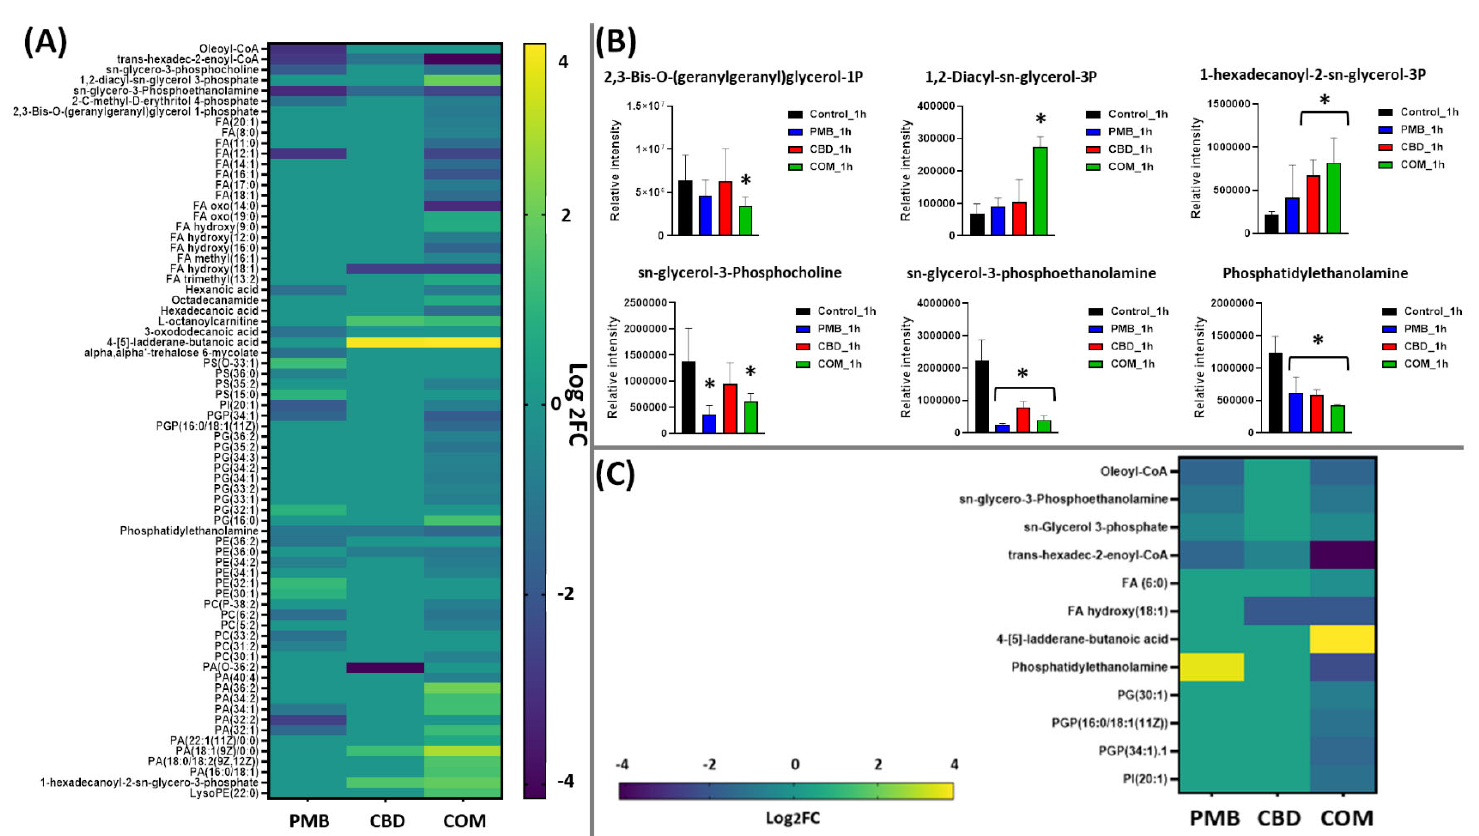
Figure 2. Perturbations of bacterial lipids. ( A ) Heatmap and ( B ) bar charts for significantly perturbed lipids in A. baumannii ATCC 19606 following treatment with polymyxin B (PMB, blue), cannabidiol (CBD, red) and the combination (COM, green) at 1 h. ( C ) Heatmap for significantly perturbed lipids in A. baumannii ATCC 19606 following treatment with polymyxin B (PMB, blue), cannabidiol (CBD, red) and the combination (COM, green) at 4 h. Lipid names are putatively assigned based on accurate mass ( ≥ 0.59 ‐ log 2 ‐ fold, p ≤ 0.05). Control, untreated samples; PE, phosphoethanolamines; PG, glycerophosphoglycerols; PS, glycerophosphoserines; PC, glycerophosphocholines; PA, glycerophosphates; LysoPE, lysophosphatidylethanolamines; PGP, glycerophosphoglycerophosphates; FA, fatty acids. * ≥ 0.59 ‐ log 2 ‐ fold, p ≤ 0.05 (one ‐ way ANOVA).